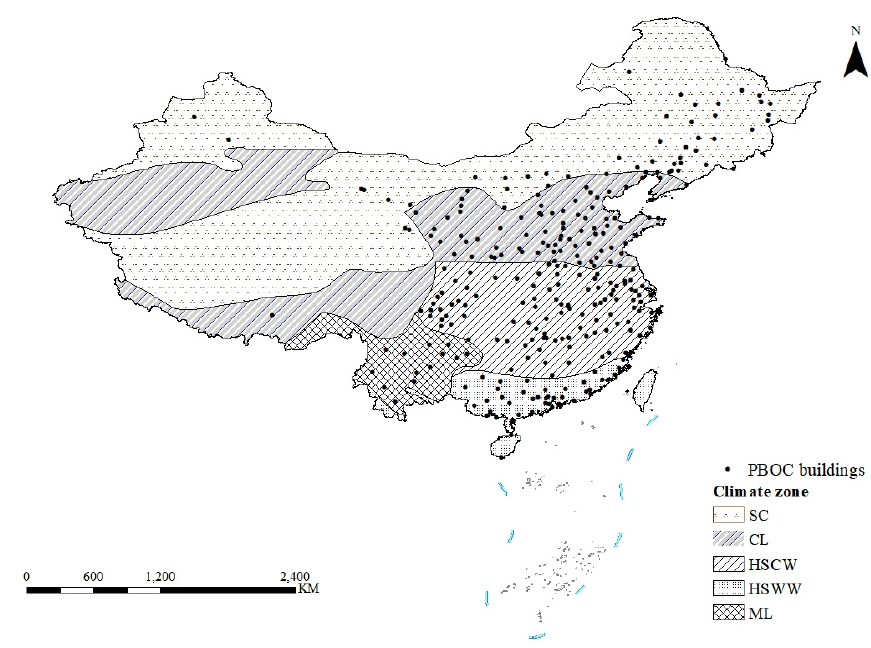
Figure 4. China’s building climate demarcation and the distribution of 288 PBOC buildings.